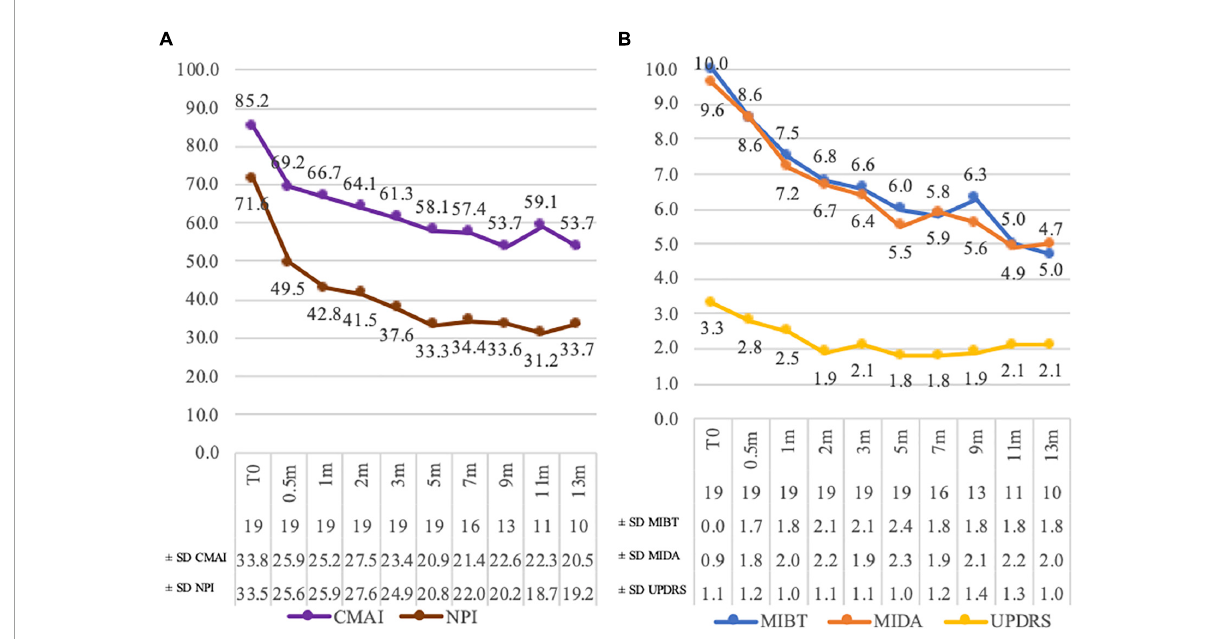
FIGURE2 Assessment score variations. Panel (A) : Cohen–Mansfield agitation score (CMAI) and neuropsychiatric inventory (NPI) scores. Panel (B) : Unified Rating Scale for Parkinson’s disease item 22 (UPDRS), most incapacitating daily activity (MIDA), and most incapacitating behavioral trouble (MIBT) scores. The number of assessed patients and the score standard deviations are in the chart legend at each time point. m = month of